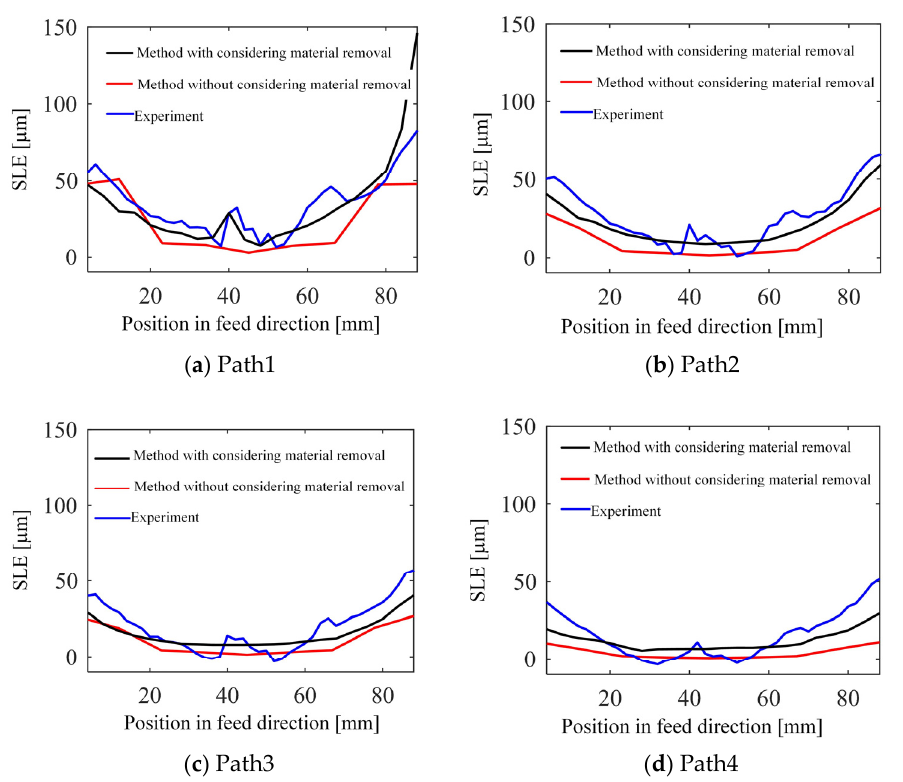
Figure 13. FRF comparison between two models.